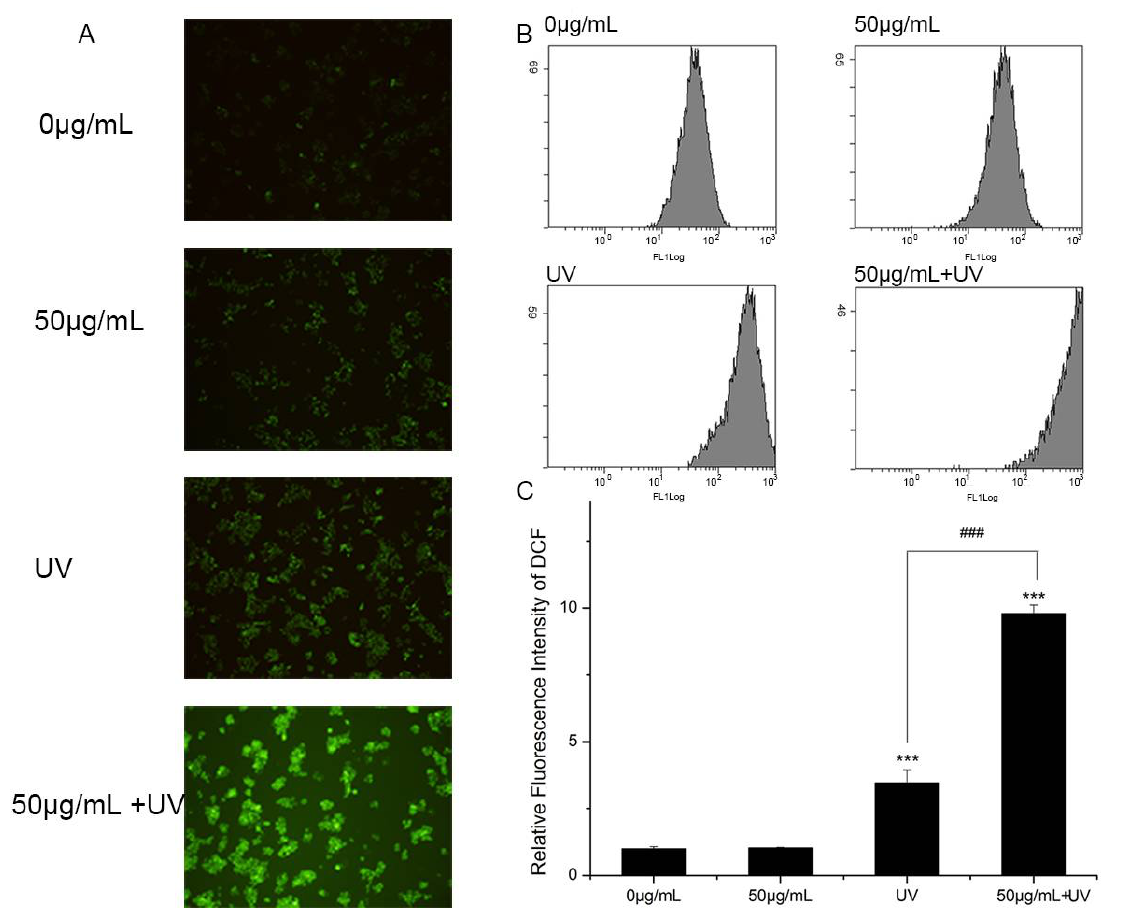
Figure 6. Reactive oxygen species (ROS) generation in HaCaT cells. Cells were treated with 0 or 50 μg/mL nano-TiO 2 P25 with or without UV irradiation. After the treatment, 2′,7′-dichlorofluorescin diacetate (DCFH-DA) was imaged by fluorescence microscopy and detected by flow cytometry. ( A ) A fluorescence microscopy image, ( B ) histograms from the flow cytometry analysis, ( C ) quantification of the fluorescence intensity of 2,7-dichlorofluorescein (DCF) (mean ± SD, n = 3, *** p < 0.001, compared with the 0 μg/mL group; ### p < 0.001, compared with the UV group).